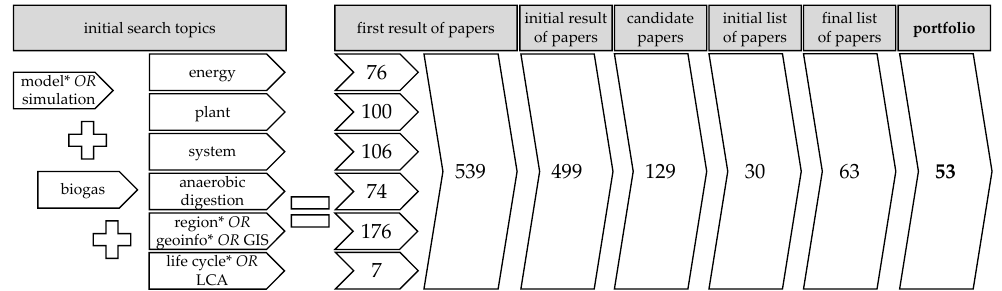
Figure 3. Result of the systematic literature search performed.